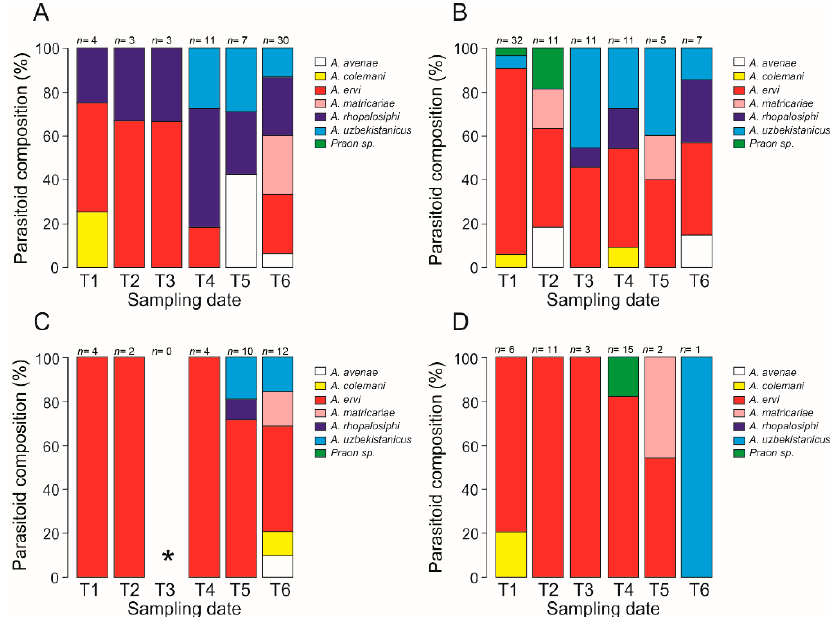
Figure 4. Parasitoid species composition according to the sampling date (T1–T6). ( A ) Zone 1 and ( B ) Zone 2 throughout 2017; and ( C ) Zone 1 and ( D ) Zone 2 throughout 2018. n = total number of individuals emerged. * No mummies were found.